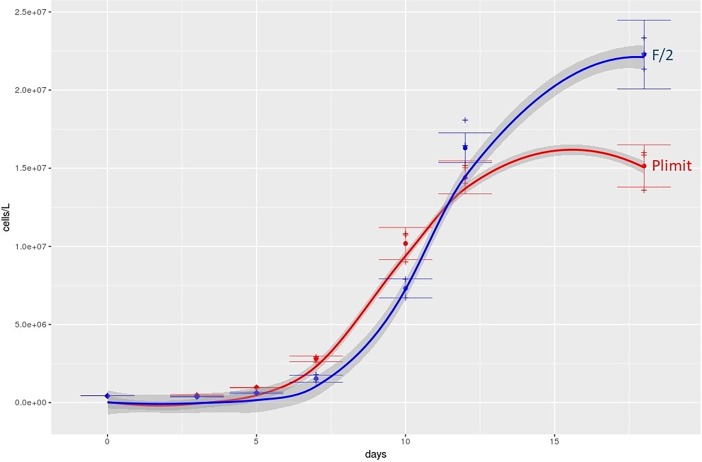
Growth curves of C. peruvianus in different phosphate conditions.Growth curve in F/2 medium is indicated in blue and growth curve in F/2 medium without added dissolved phosphate (P-limit) in red. Averaged cell concentrations throughout 18 days of culture duration and fitted models for growth in batch cultures are presented. Crosses are measured cell concentrations, dots give the averages for the given medium. Lines show the resulting model values and the grey area around the lines represent the 95% confidence interval for the respective model.